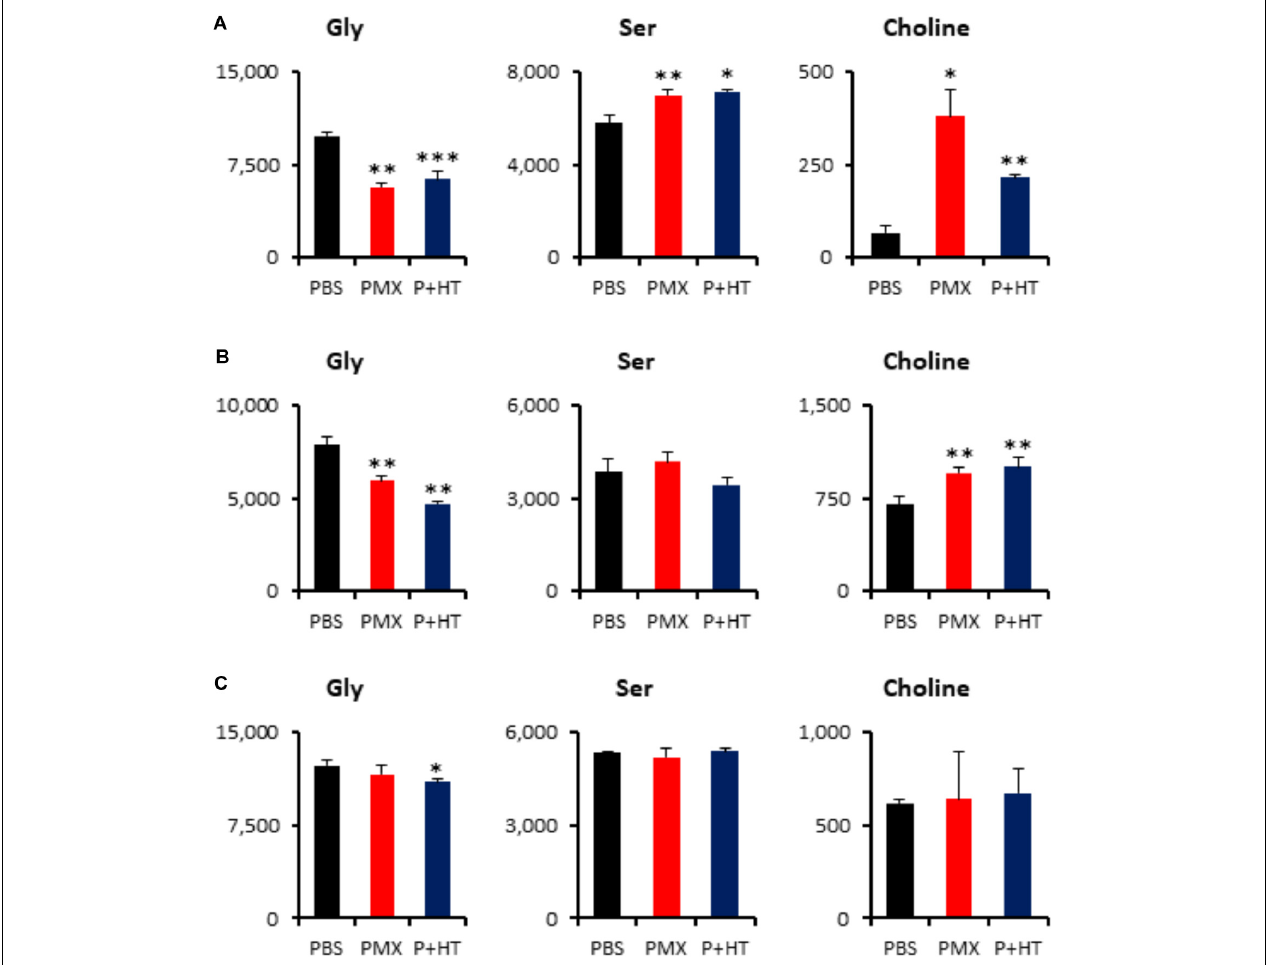
FIGURE 5 | Quantification of metabolites involved in the one-carbon pathway. Intracellular concentration (pmol/million cells) of key metabolites involved in the one-carbon metabolic pathway after treatment with pemetrexed is shown. Error bars indicate s.d. (n = 3). ∗ P < 0.05, ∗∗ P < 0.01, ∗∗∗ P < 0.001 vs. control by Welch t -test. Total metabolites were extracted with methanol from MSTO-211H (A) , TCC-MESO2 (B), or NCI-H2452 (C) cells treated with PBS (black), 1 µ M PMX (red) or 1 µ M PMX + HT (blue) for 6 h. Representative metabolites such as glycine (Gly), serine (Ser), and choline are